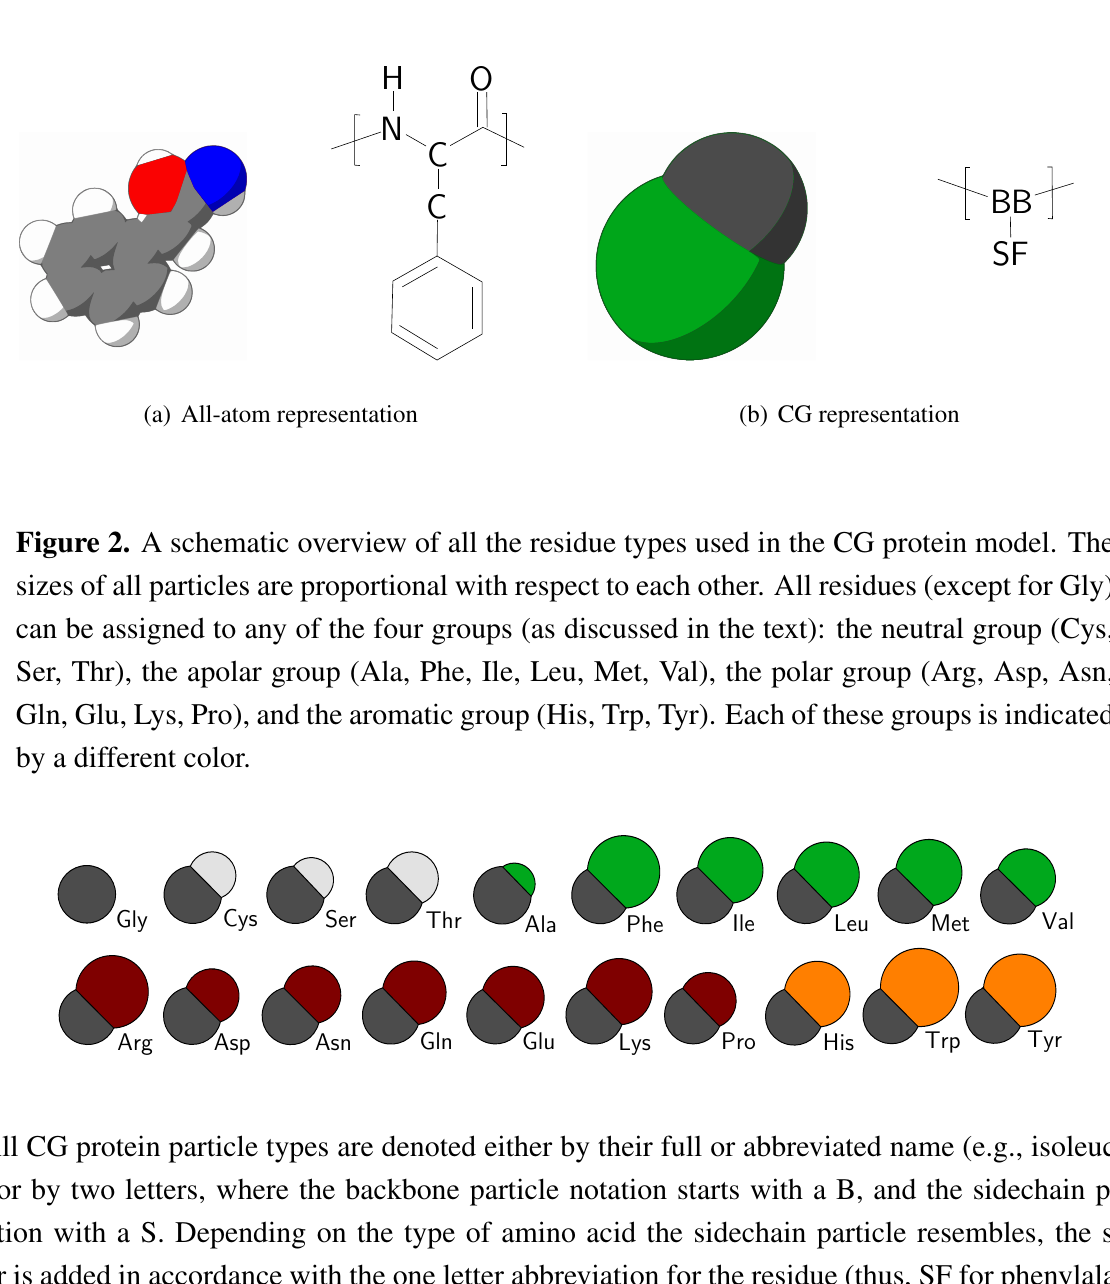
atom, whereas α -C bond vector. The brackets represent α β